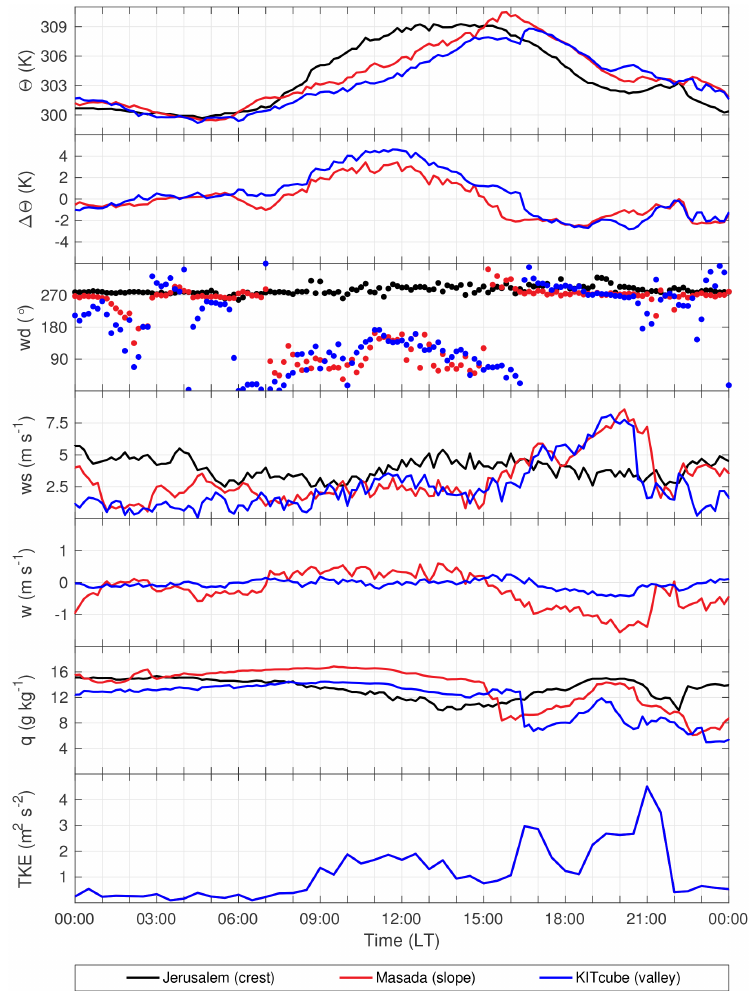
Figure 9. Time series of potential temperature ( (cid:50) ), potential temperature difference between crest and slope/valley ( (cid:49)(cid:50) ), wind direction (wd), wind speed (ws), vertical wind speed (w), specific humidity ( q ), and turbulent kinetic energy (TKE) for Jerusalem (crest), Masada (slope), and KITcube location (valley) on 16 August